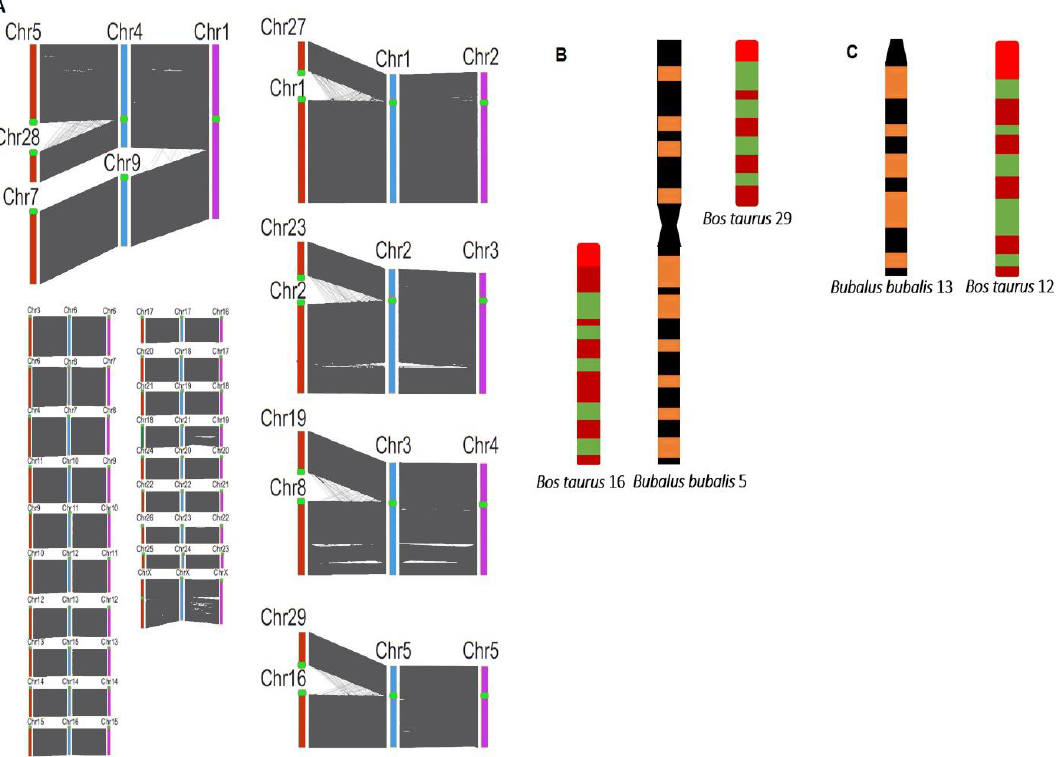
Figure 2. Cytogenetics of buffaloes (river and swamp) and cattle ( Bos taurus ). ( A ) Synteny analysis of buffaloes (river and swamp) and cattle. The cattle chromosomes are presented in red, river buffalo chromosomes in blue, and swamp buffalo chromosomes in pink and centromeres in red dots [21]. ( B , C ) The similar banding pattern of different chromosomes of buffaloes and cattle [20].